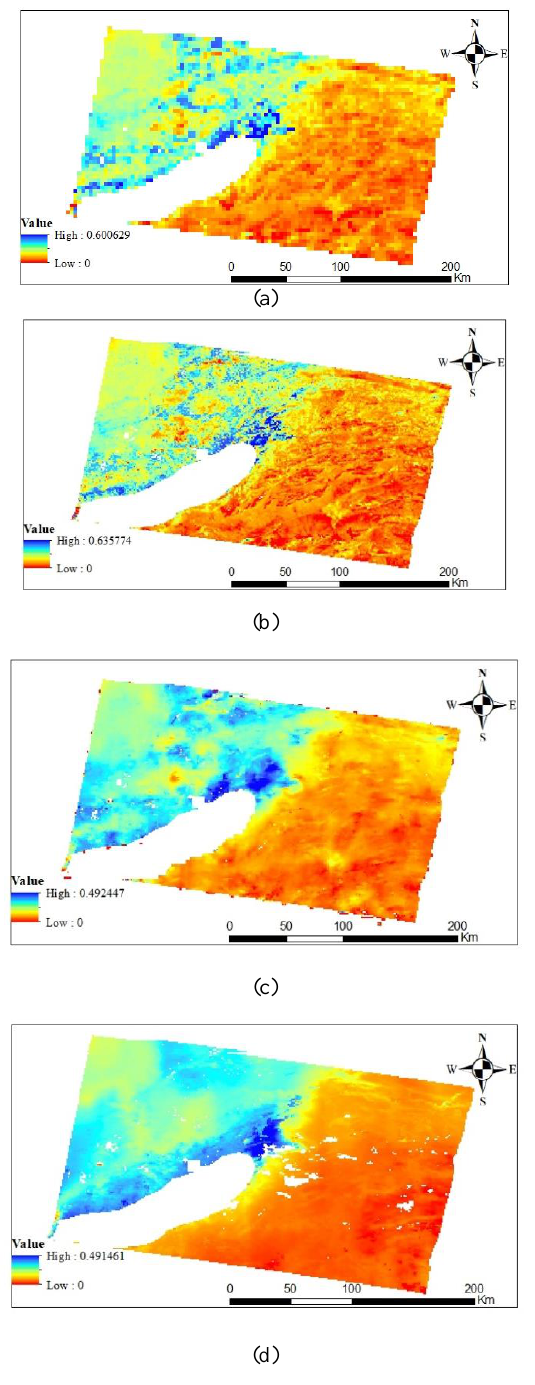
Figure 2 . (a) 3 km SMAP soil moisture product, (b) 1 km SMAP soil moisture product which has been already downscaled using Sentinel-1, (c) 1 km SMAP soil moisture product downscaled using regression method and (d) 1 km SMAP soil moisture product downscaled using neural network